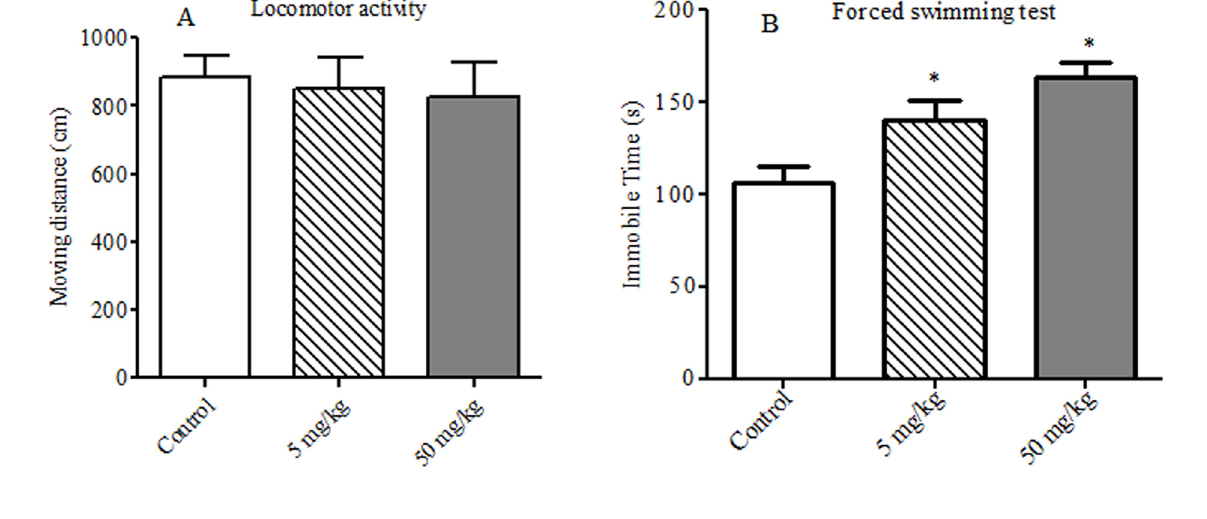
Fig 2. The effects of TDBP-TAZTO (5 and 50 mg/kg) on the locomotor activity (A) and the durations of immobility in FST (B) in rats. The results are presented as mean ± SE (n = 10/group). * p < 0.05, vs. control group.